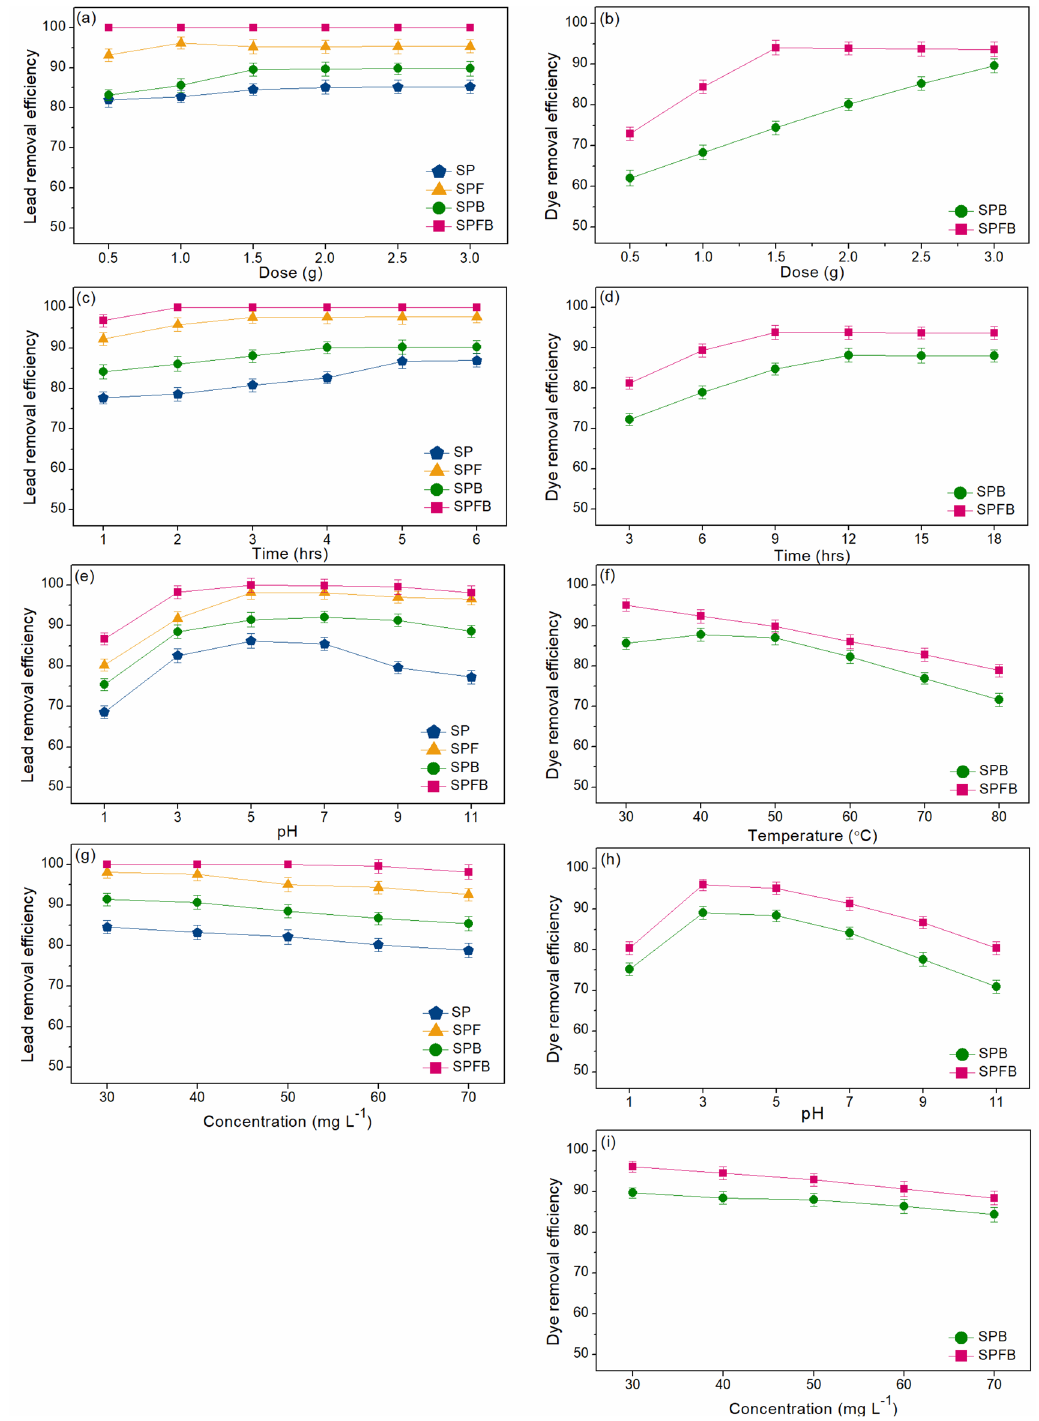
Figure 5. Batch experiments for lead and RB4 dye removals on the effects of ( a , b ) dose, ( c , d ) contact time, ( f ) temperature, ( e , h ) pH, and ( g , i ) concentration of sawdust powder (SP), sawdust powder doped iron (III) oxide- hydroxide (SPF), sawdust beads (SPB), and sawdust powder doped iron (III) oxide-hydroxide beads (SPFB), and the results are demonstrated in Fig. 5g. The control condition was a sample volume of 200 mL, a temperature of 25 °C, a shaking speed of 200 rpm, and the optimum dose of 2 g (SP) or 1 g (SPF) or 1.5 g (SPB) or 0.5 g (SPFB) and contact time of 5 h (SP) or 3 h (SPF) or 4 h (SPB) or 2 h (SPFB), and pH of 5. Lead removal efficiencies of all materials were decreased with the increase of concentration because of the decreasing available active sites for adsorbing lead ions 7 . Lead removal efficiencies from 30 to 70 mg L −1 of SP, SPF, SPB, and SPFB were 78.82–